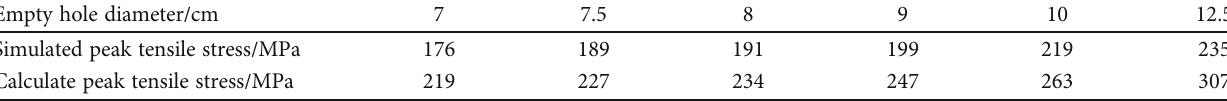
Table 5: Peak tensile stress of the hole wall with di ff erent hole